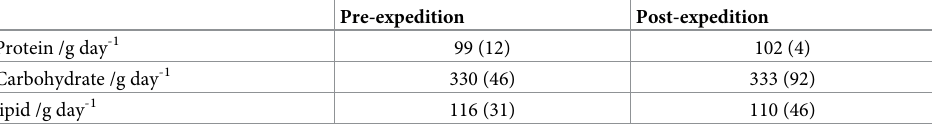
Table 2. Average [median (IQR)] substrate utilisation pre- and post-expedition for the during the 24hour mea- surement period.